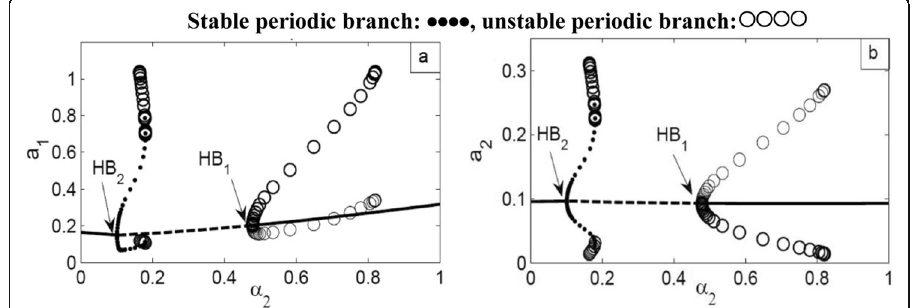
Fig. 9 Bifurcation diagram of nonlinear control parameter α 2 as the bifurcation parameter